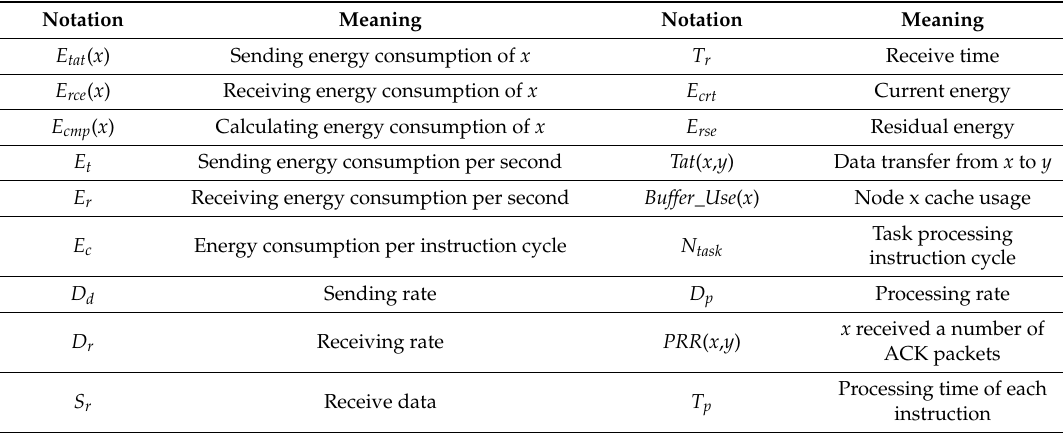
Table 1. Notation used in the